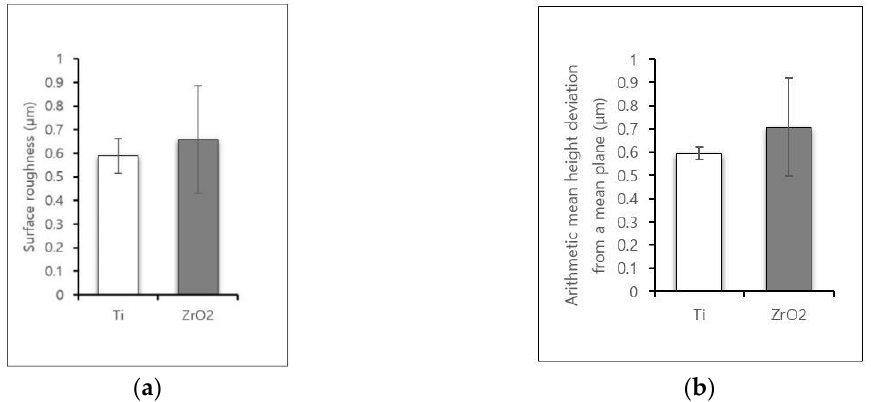
Figure 3. Surface roughness-related parameters obtained by CLSM. ( a ) Ra (surface roughness); ( b ) Sa (arithmetic mean height deviation from a mean plane.